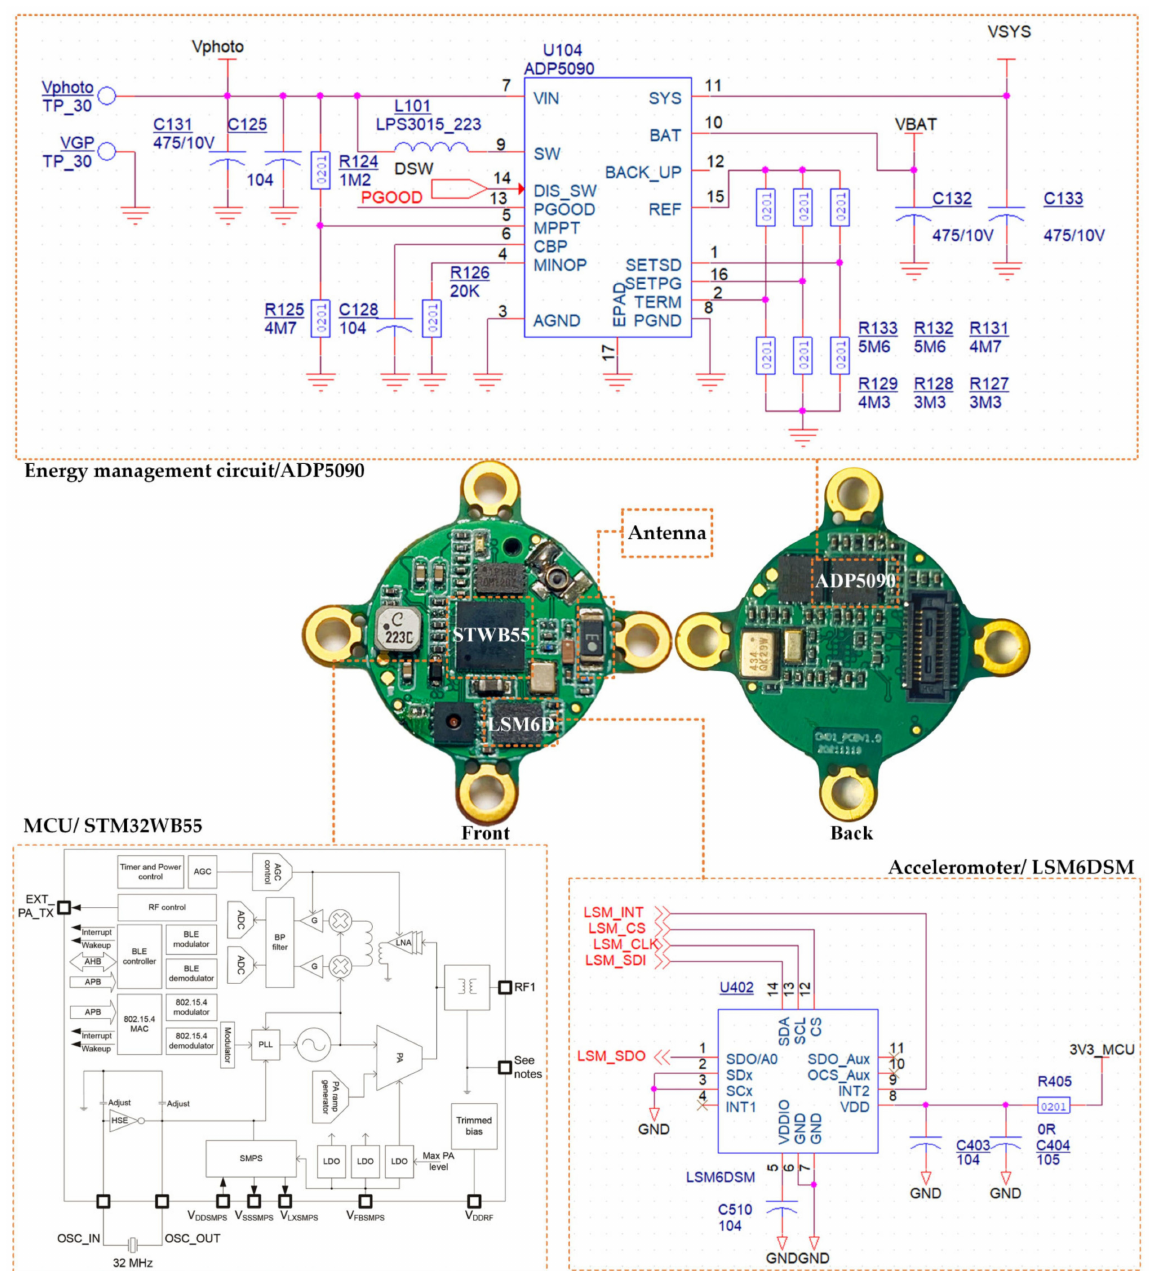
Figure 3. Main board of